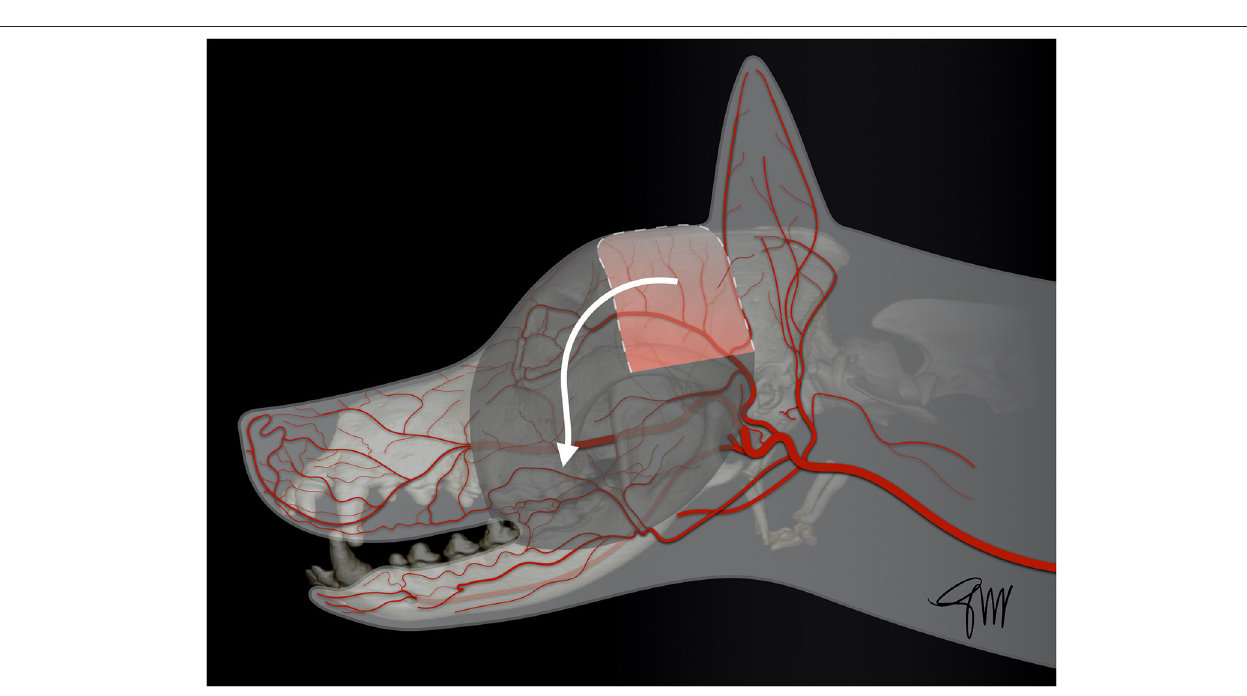
FIGURE 10 | Drawing depicting the surgical limits and extent of rotation of a superficial temporal myocutaneous axial-pattern flap.